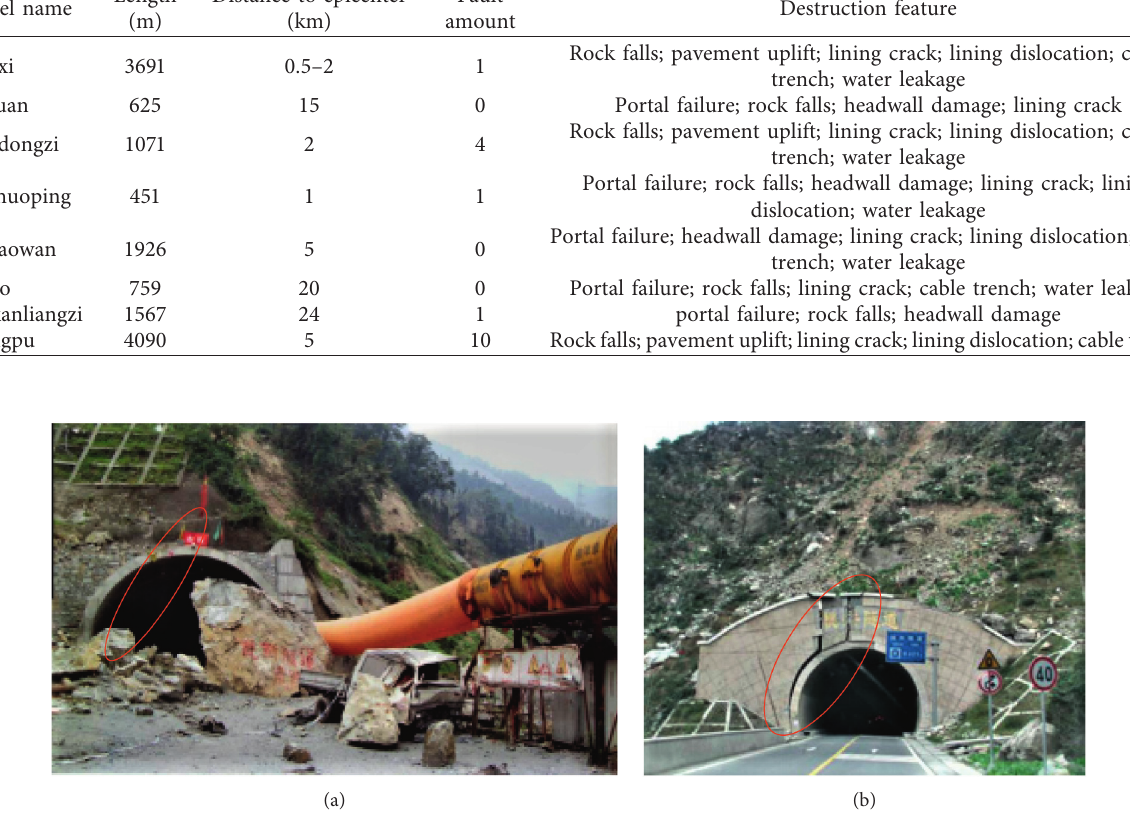
Figure 2: Damage patterns of tunnel linings during the Wenchuan earthquake 2008, China. (a) Damage at the entrance of Longxi tunnel [8]. (b) Cracking at the portal of Taoguan tunnel